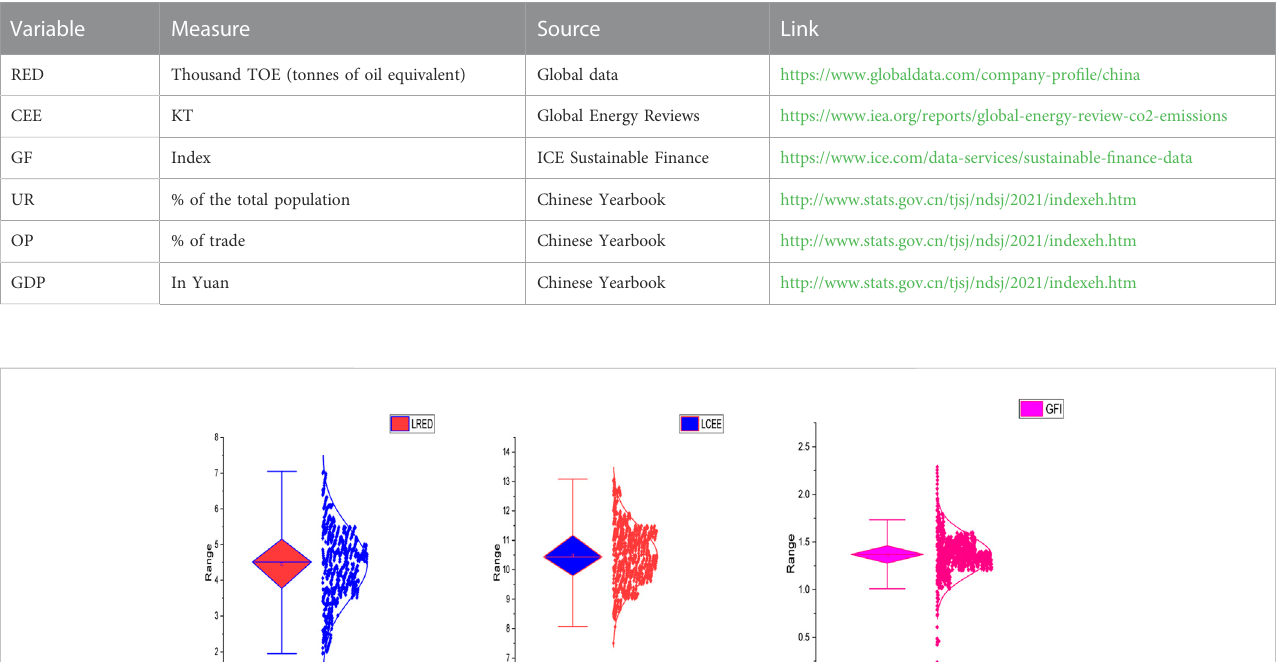
TABLE 1 Variables units and source of data.